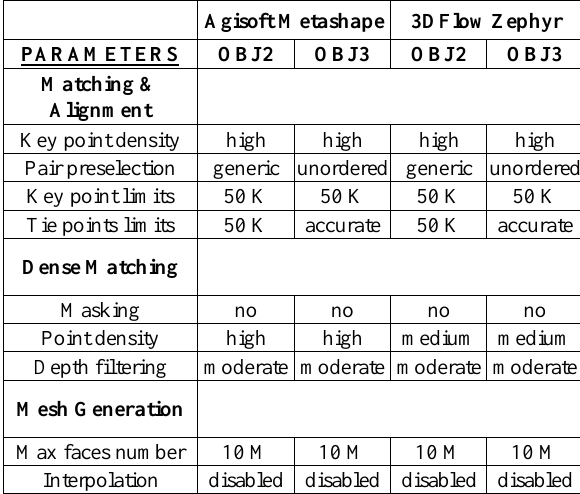
Table 5: photogrammetric processing parameters